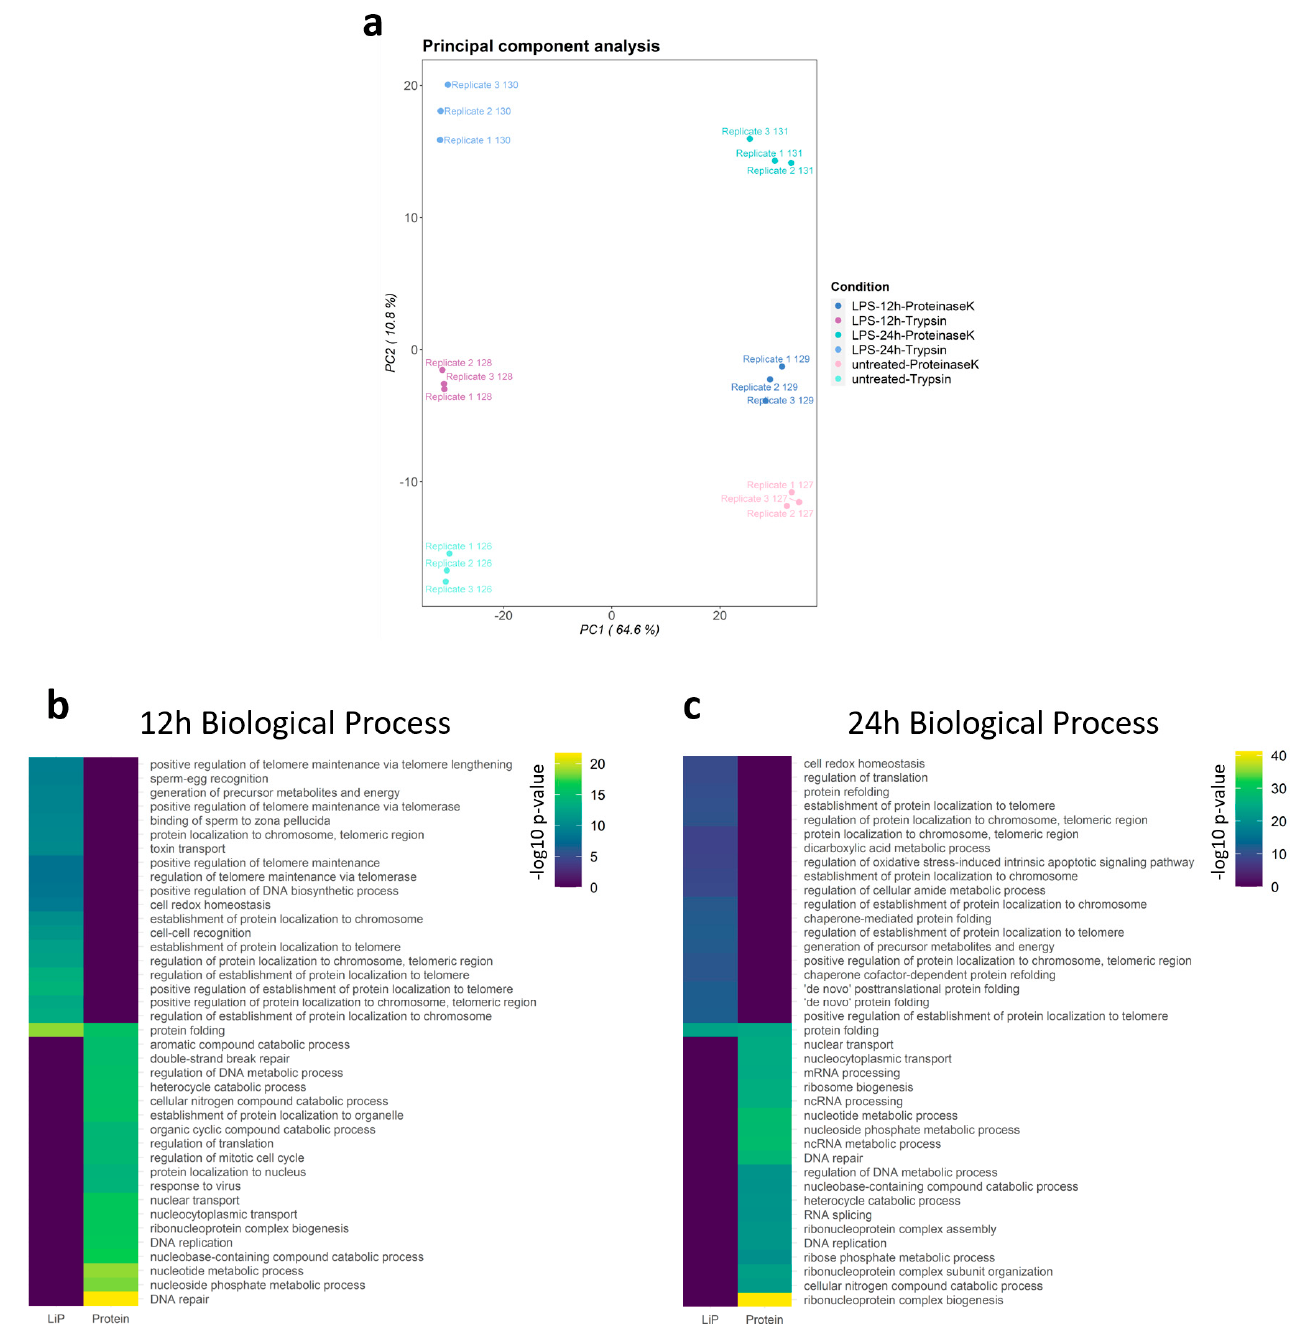
Figure 3. Landscape of the structure-ome during macrophage activation. ( a ) principal component analysis (PCA) of LiP-MS results; ( b , c ) Top 20 GO biological process enrichment comparison of protein abundance and structural changes after LPS stimulated for 12 h or 24 h.